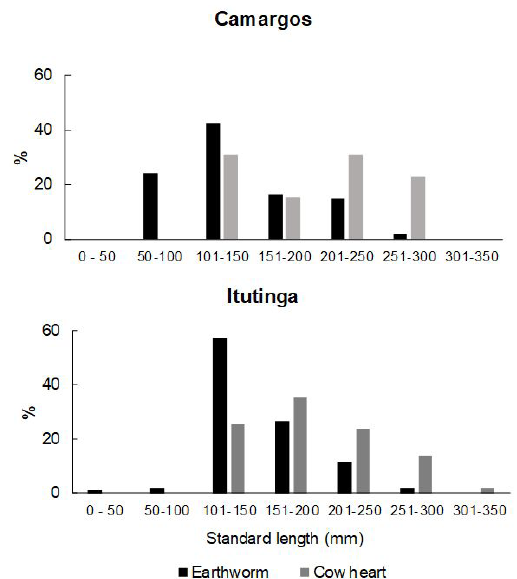
Figure 2. Percentages of mandi ( Pimelodus maculatus ) by classes of standard length (SL) sampled with earthworms or cow heart in the tailrace of the Camargos and Itutinga hydropower